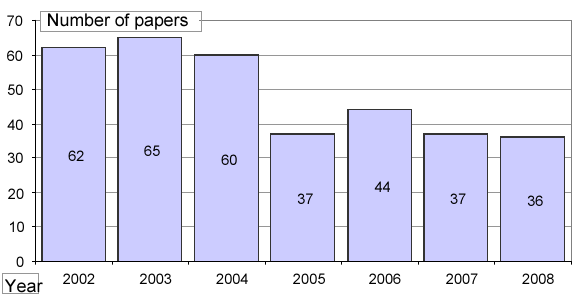
Fig. 1. Annual number of papers